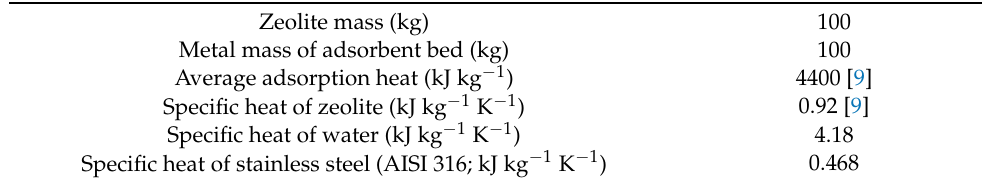
Table 3. Properties of materials used in the adsorbent bed.